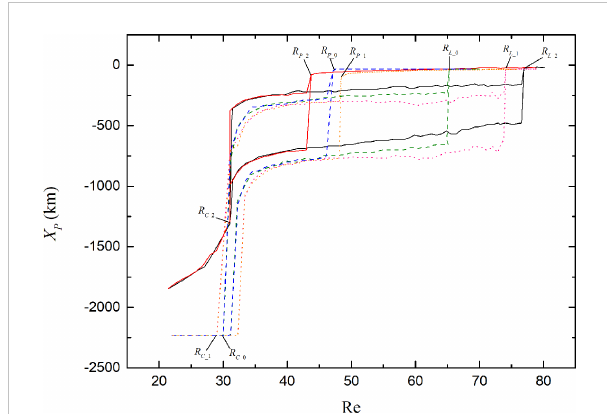
FIGURE 2 Hysteresis curves of the WBC with no island, one island, and two islands in the gap, where X P is the westernmost position of the y = Q /2 streamline of the WBC, with 0 standing for the position of the barrier; the Reynolds number is de fi ned as Re = Q / A h ; Re C -2 (Re C -0 , Re C -1 ) is the critical value of the WBC in the gap with two islands (no island, one island) shifting from the penetrating to the eddy- shedding regime. Re L -2 (Re L -0 , Re L -1 ) is the critical value of the WBC in the gap with two islands (no island, one island) shifting from the eddy-shedding to leaping regime. Re P -2 (Re P -0 , Re P -1 ) is the critical value of the WBC in the gap with two islands (no island, one island) shifting from the leaping to eddy-shedding regime. The double curves indicate the WBC in the periodic eddy-shedding regime. WBC, western boundary